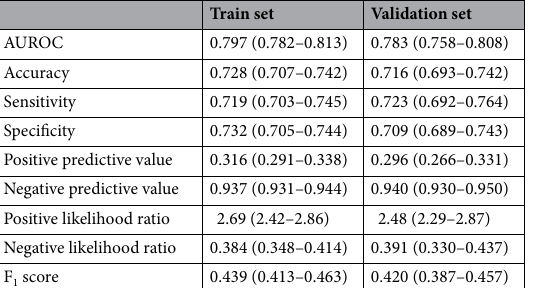
Table 2. Model performance on train and validation set of stacking ensemble machine learning. Proportion or ratio (bootstrapped 95% CI).